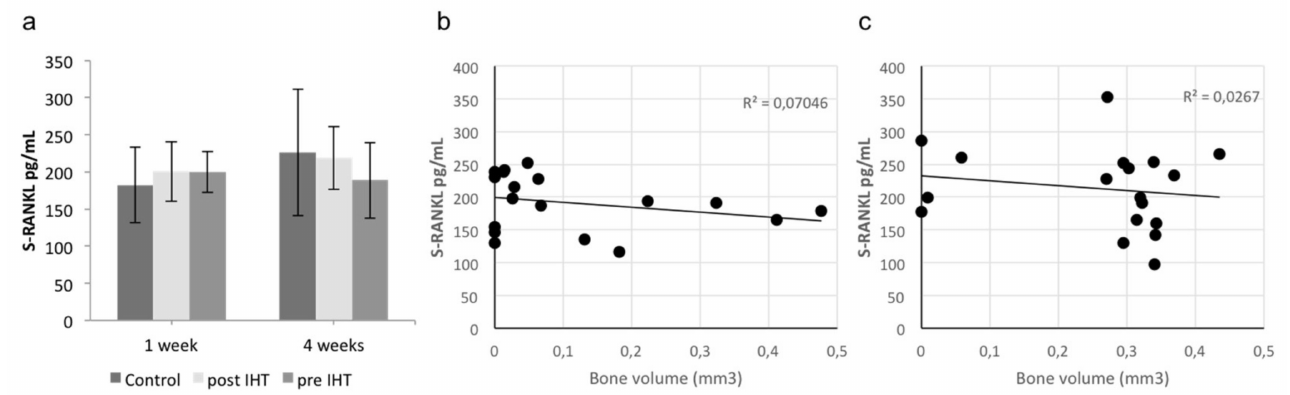
Figure 6. Osteoclast stimulating factor in serum. ( a ) RANKL expression in serum after 1 and 4 weeks. Vertical axis represents p-RANKL concentrations (pg/mL). Horizontal axis represents time visualized by different treatment groups. Average level was 200 pg/mL (range 97–350 pg/mL). No differences were observed between the groups. ( b , c ) RANKL and bone-volume correlation after 1 week and 4 weeks. Vertical axes represent S-RANKL concentrations (pg/mL). Horizontal axes represent bone volume (mm 3 ). Correlation coefficients were investigated for the clustered groups at each time point. No correlation between bone-graft volume and RANKL concentration in serum was found. Control, n = 12 biological independent samples. IHTs, n = 6 biological independent